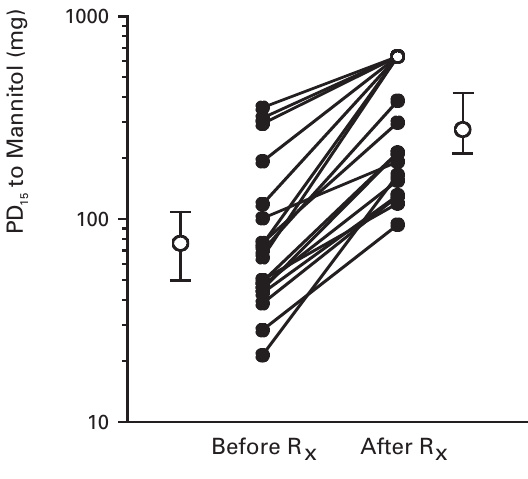
Before Rx After Rx